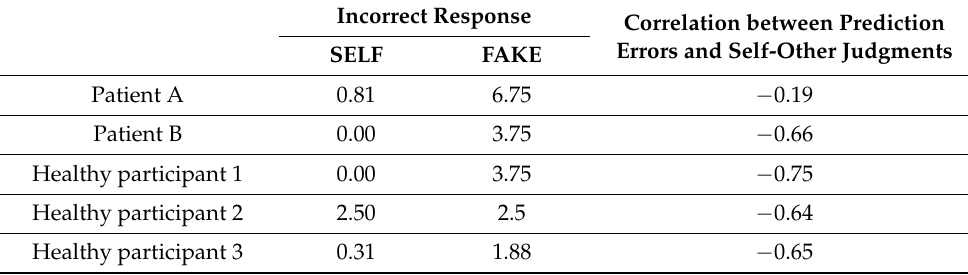
Figure 5. Prediction errors and self-other judgments in the FAKE condition. Self-other judgment refers to a nine-point scale ranging from nine (completely self-movement) to one (completely other’s movement). Moderate or high correlations were observed in PB ( r = − 0.66) and three healthy participants ( r = − 0.75; r = − 0.64; r = − 0.65), whereas in PA, a low correlation was observed, r = − 0.19. Table 2. A summary of self-other attribution results.